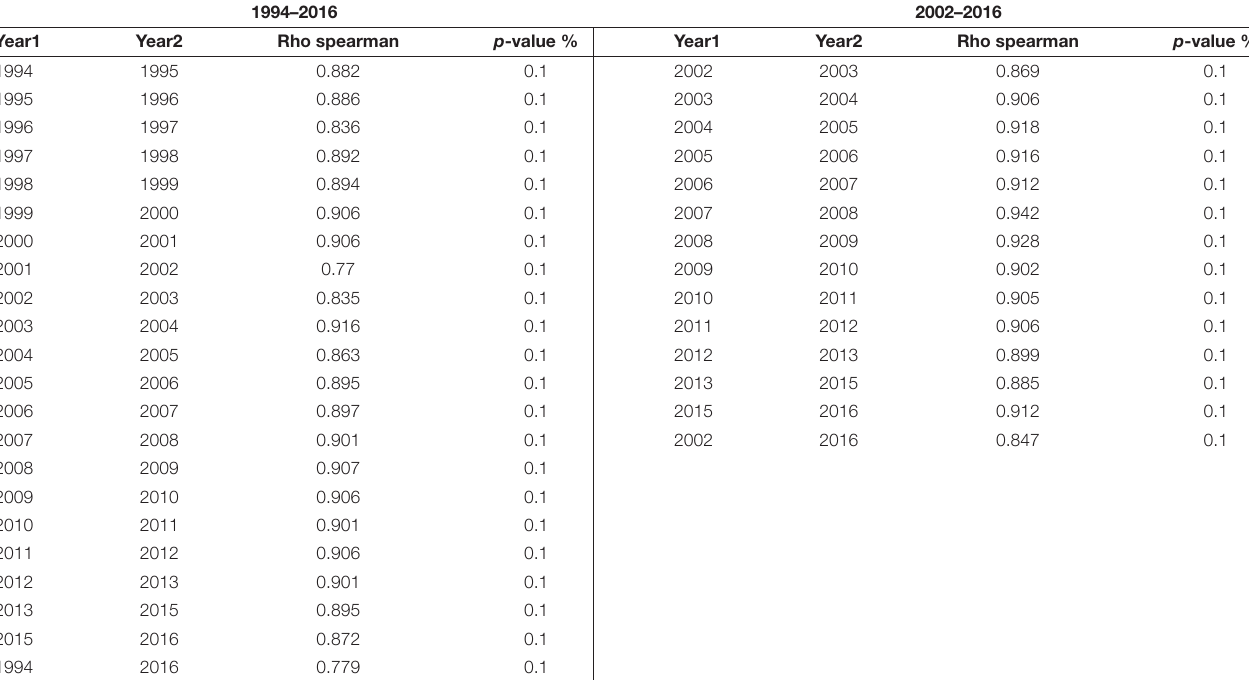
TABLE 4 | Results of the RELATE test for both time